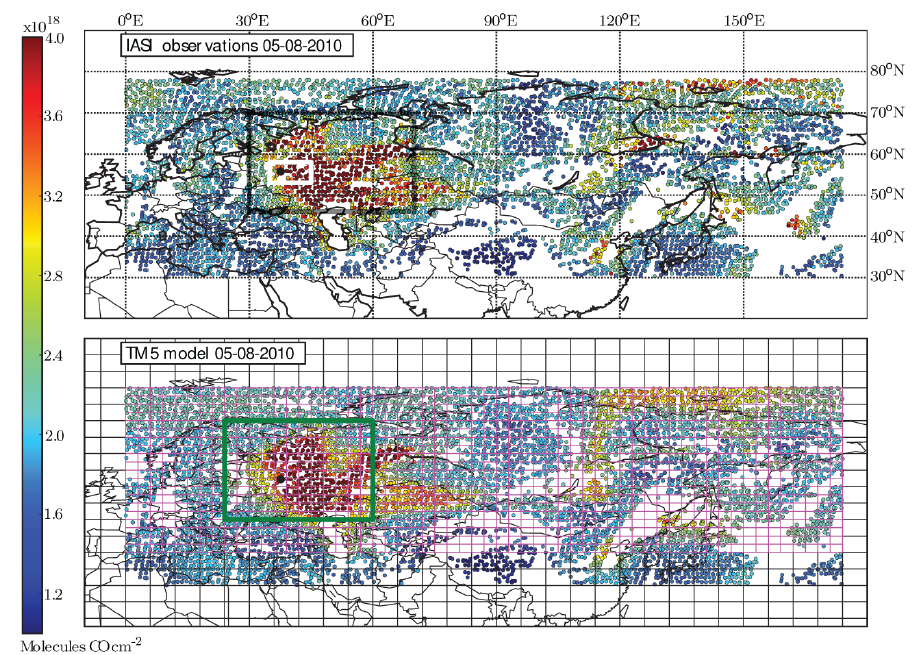
Fig. 1. Total CO columns for the 5 August 2010 as measured by IASI (upper panel) and calculated by the TM5 model with optimised emissions (lower panel), based on prior emission scenario MERGED (see Table 1). The lower panel shows the grid definition for this project. The black grid represents the global 6 ◦ × 4 ◦ resolution, the light pink grid the 3 ◦ × 2 ◦ region and a 1 ◦ × 1 ◦ horizontal resolution is employed within the green square. The black circle indicates Moscow, and the coloured circles represent individual IASI observations. The white and black box in the upper panel refer to region R1 and R2, respectively, in Fig.